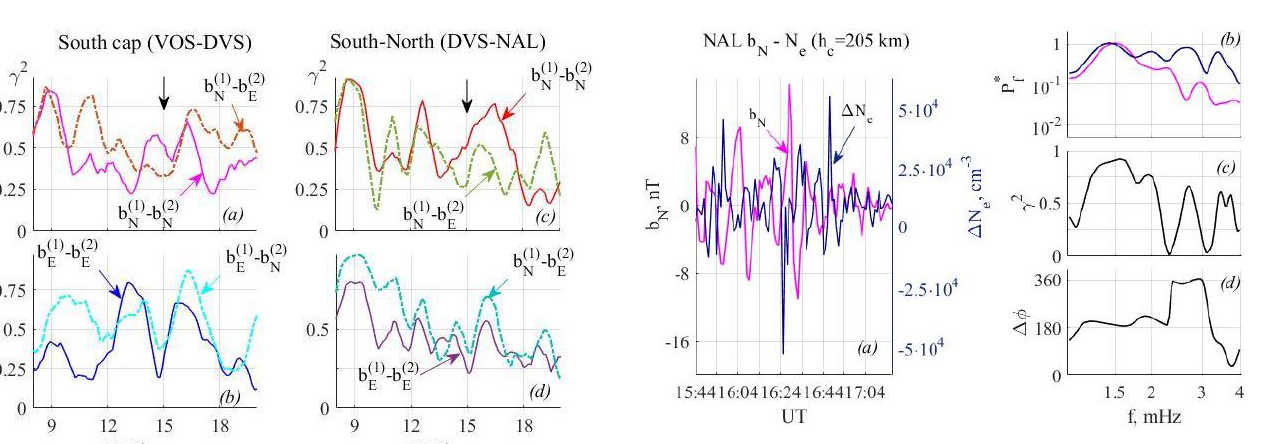
Figure 13. (a) Pulsations in the b N component at NAL and fluc- tuations of N e in the altitude band from 190 to 220km during the interval starting at 15:44UT; (b) the PSD spectra; (c) the spectral coherence; and (d) the phase differences are shown. at NAL is shown in Fig. 13a. The spectral power of both time series is shown in Fig. 13b, their spectral coherence is shown in Fig. 13c, and the phase difference is shown in Fig. 13d. The analysis indicates a common spectral maxi- mum at f 1 = 1 . 5 mHz (Fig. 13b) with a wide coherence max- imum with γ max ≈ 0.9 (Fig. 13c). The pulsations are in anti- phase with one another, as is clearly seen from both the time series and the phase difference, which is nearly π at the f 1 frequency (Fig.